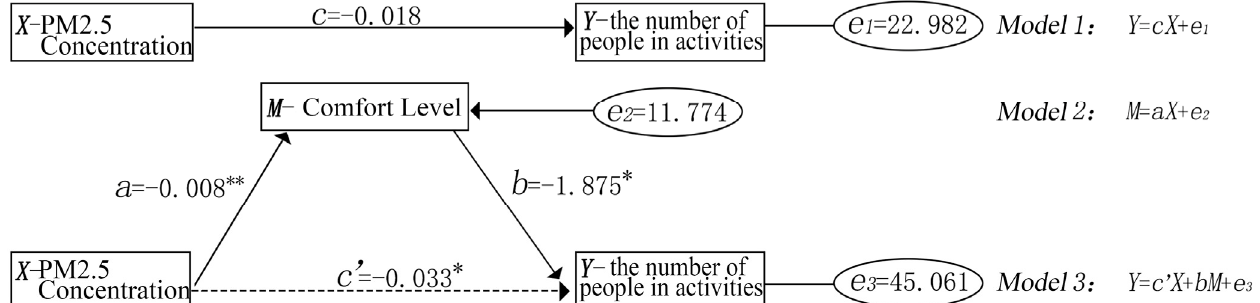
Figure 8. Mediating effects model of the comprehensive comfort level. * p < 0.05, ** p < 0.01.